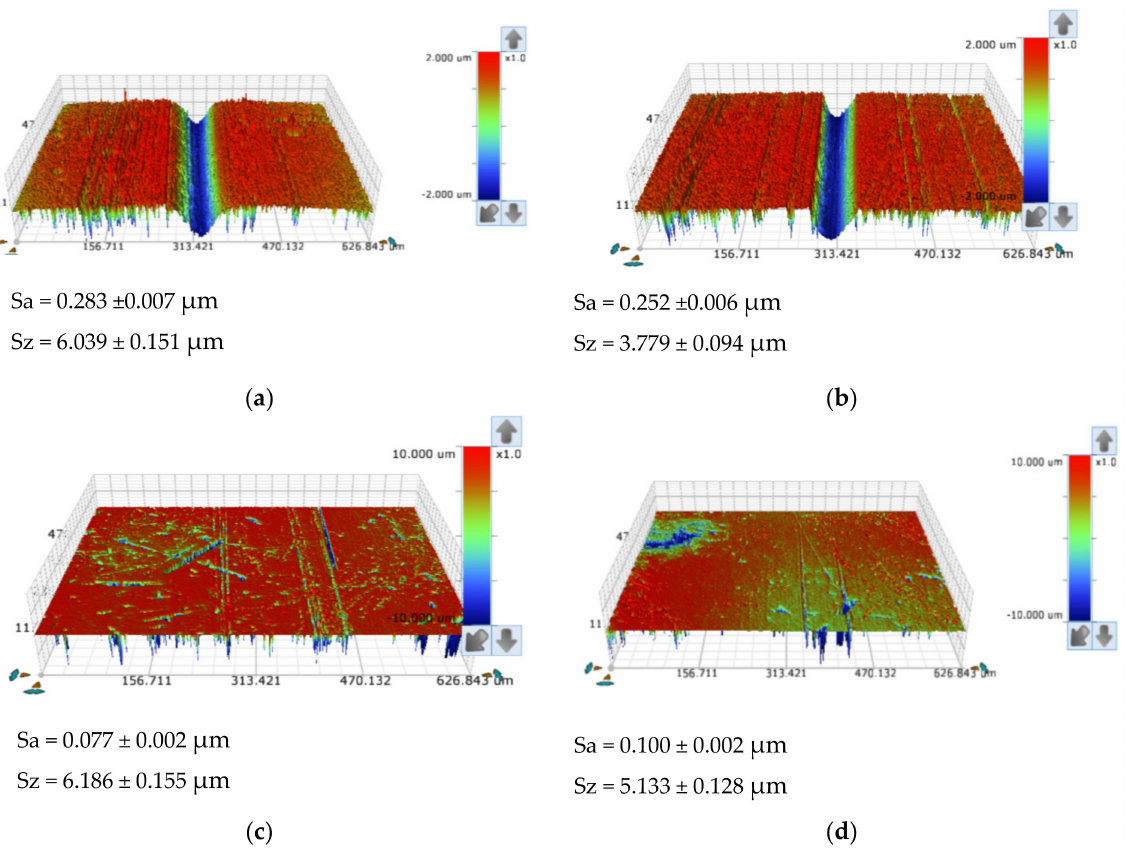
Figure 22. Representative images of the optical profilometry of the track surface of the test balls for diamond powder (1–2 µ m): ( a ) AISI 52100; load 0.2 N, ( b ) AISI 52100; load 0.5 N, ( c ) SS AISI 304; load 0.2 N, ( d ) SS AISI 304; load 0.5